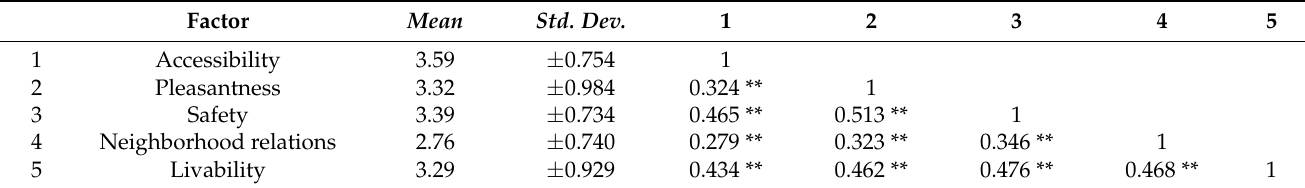
Table 3. Descriptive statistics and correlations between factors.